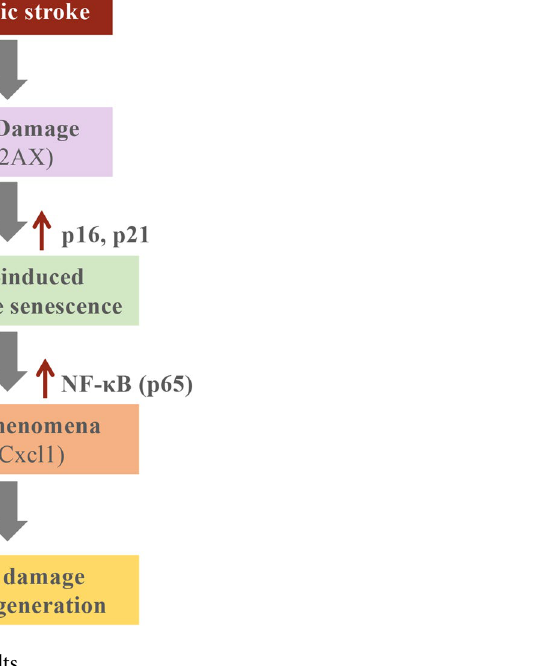
Figure 5. Graphical summary of the